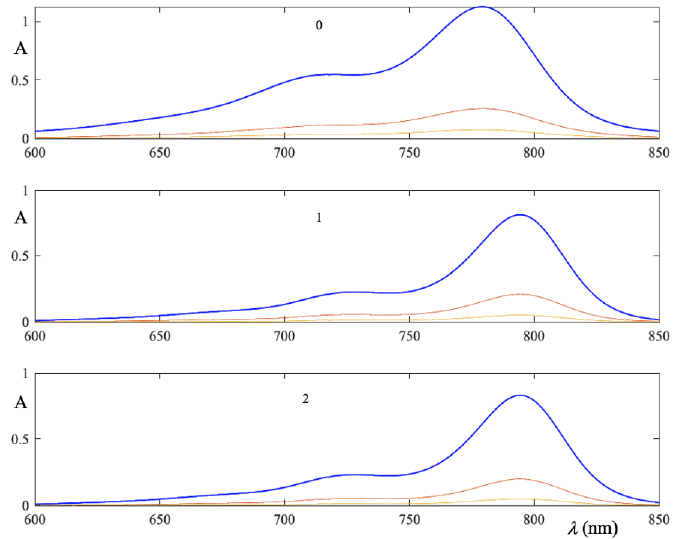
Figure 6. Absorptionspectrum in ternary LAP-ICG-water system with constant LAP mass fraction. By varying the ICG concentration, the absorption peaks do not shift, they only decrease in intensity. The number in the plot indicates the percentage (m/m) of LAP.